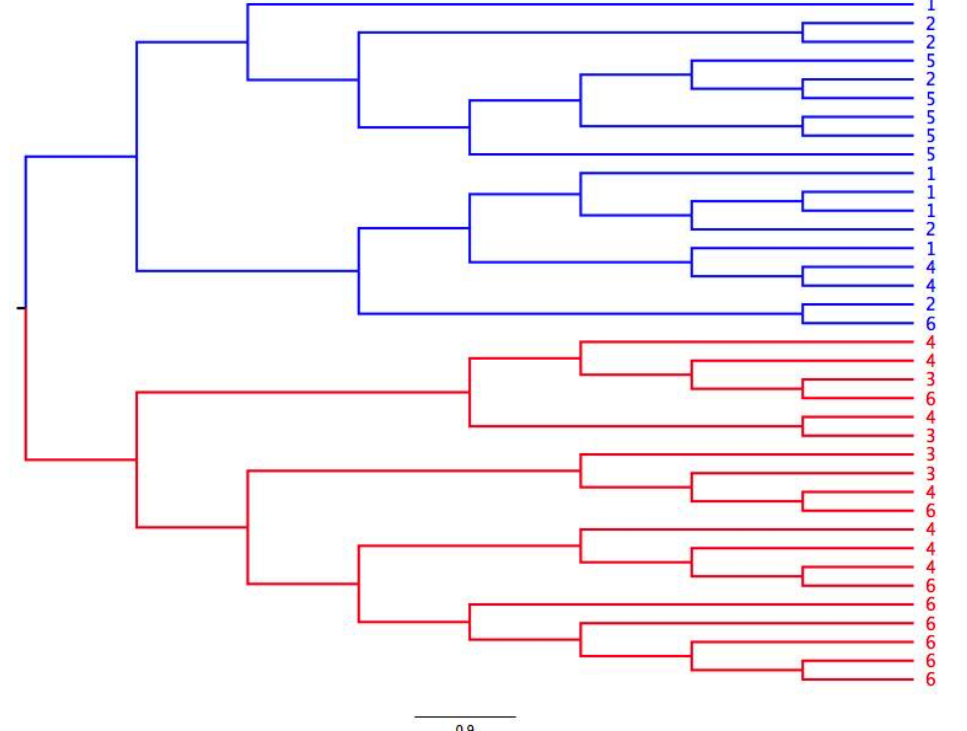
Fig. 2. UPGMA tree of the studied populations based on the morphological data (Populations 1-6 are according to Table